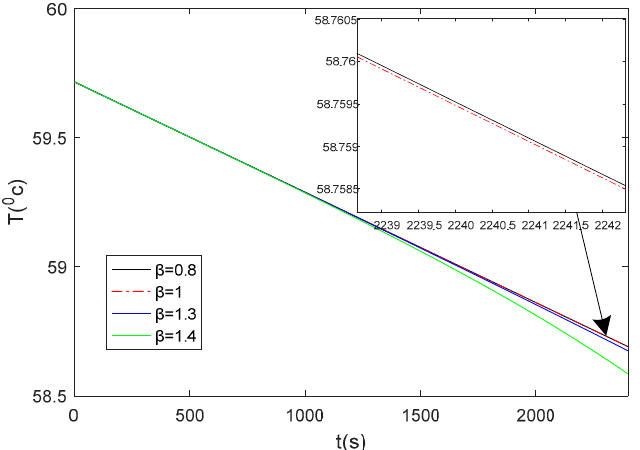
Figure 4. Pipeline temperature at different fractional-order β = 0.8, 1, 1.3, 1.4 ( λ = 0.6).